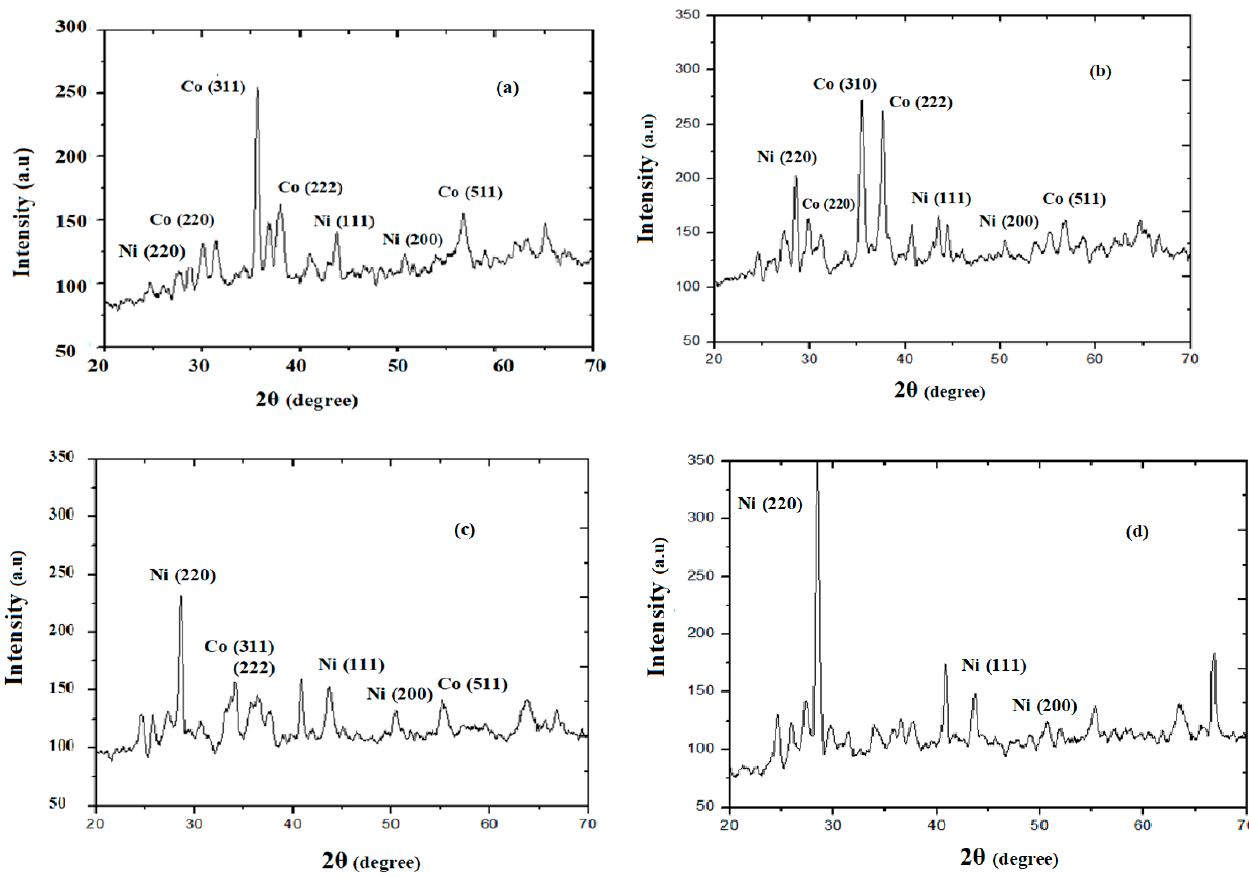
Figure 2. XRD pattern of CoCr 2 O 4 and Co 1 − x Ni x Cr 2 O 4 : ( a ) x = 0.2, ( b ) x = 0.4, ( c ) x = 0.6, and ( d ) x = 0.8.